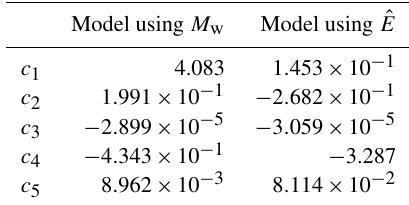
Table 1. Parameters for ground-motion